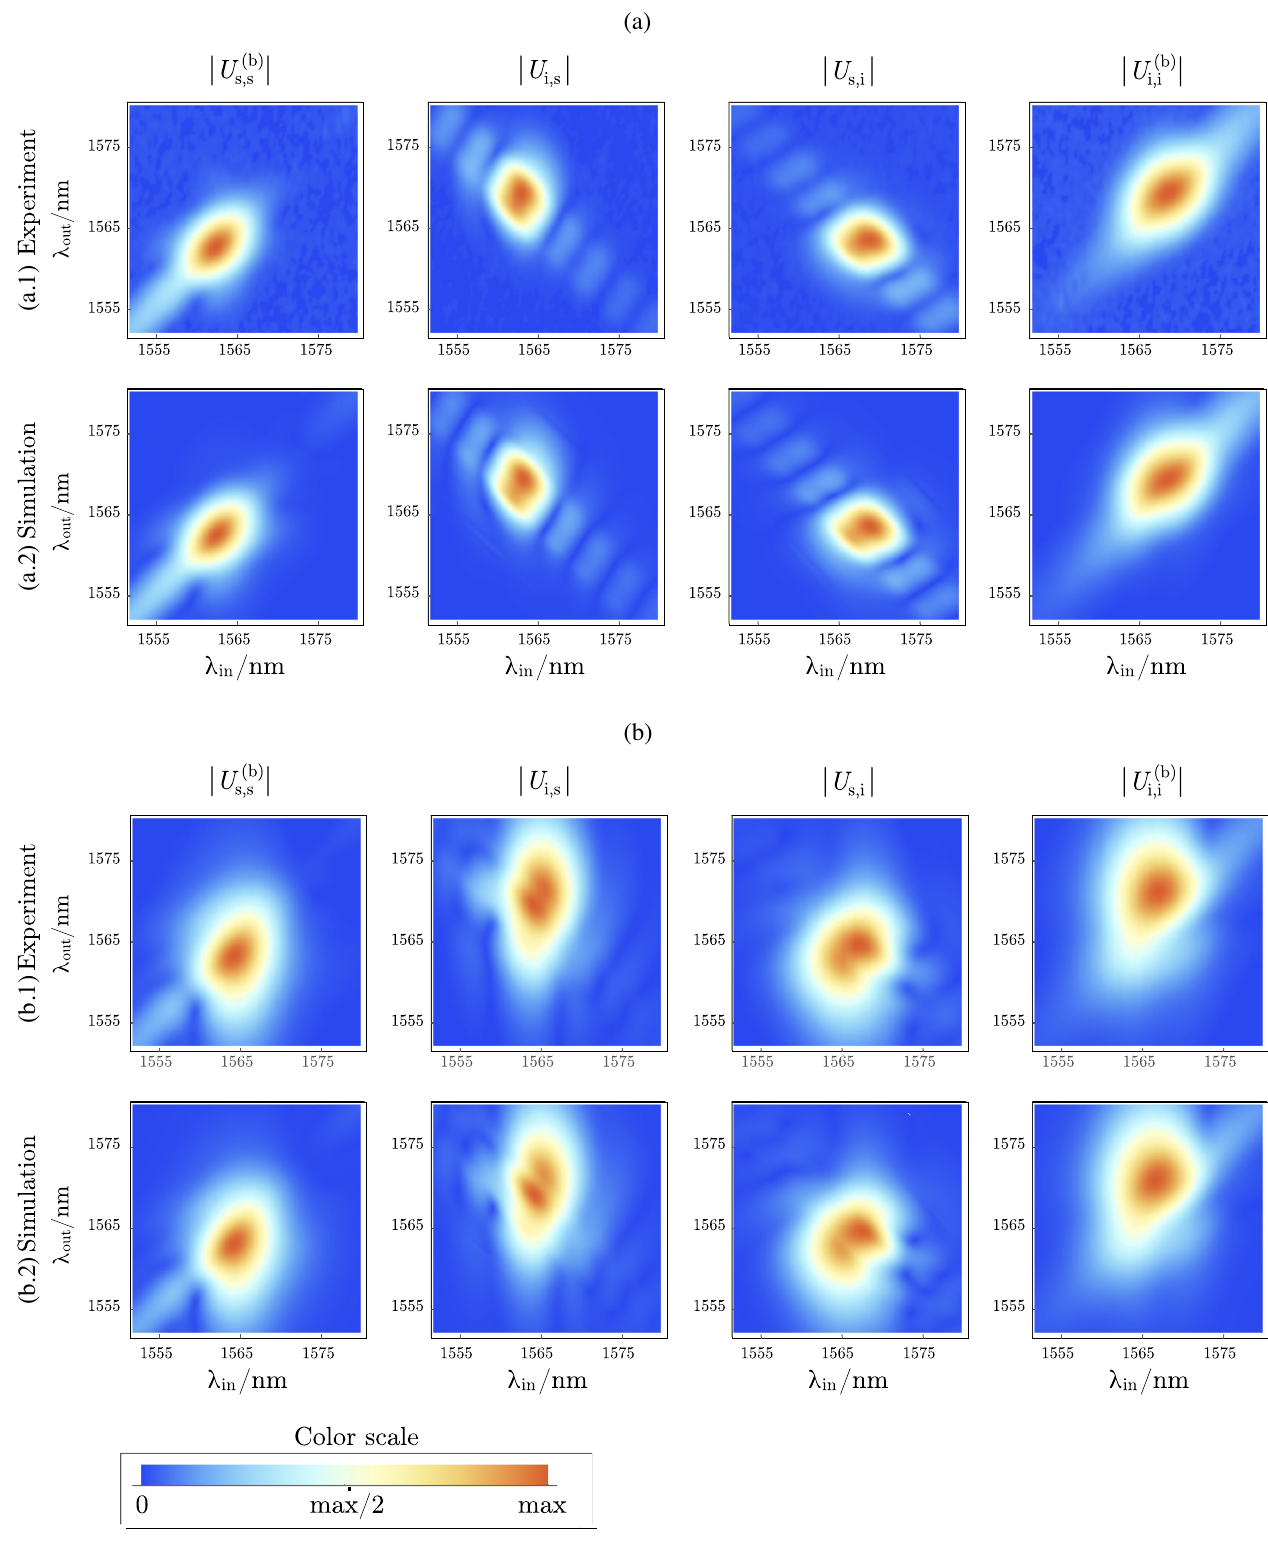
FIG. 3. All measured and modeled TF amplitudes, in the low- and high-gain regimes, corresponding to strong and weak squeezing. The color scale is normalized separately for each density plot. The TF amplitudes are plotted as a function of wavelength instead of angular frequency, where they are connected by λ ¼ 2 π c= ω . (a) Low squeezing (approx. 2 photons/pulse spontaneous emission) (b) High squeezing (approx. 60 photons/pulse spontaneous